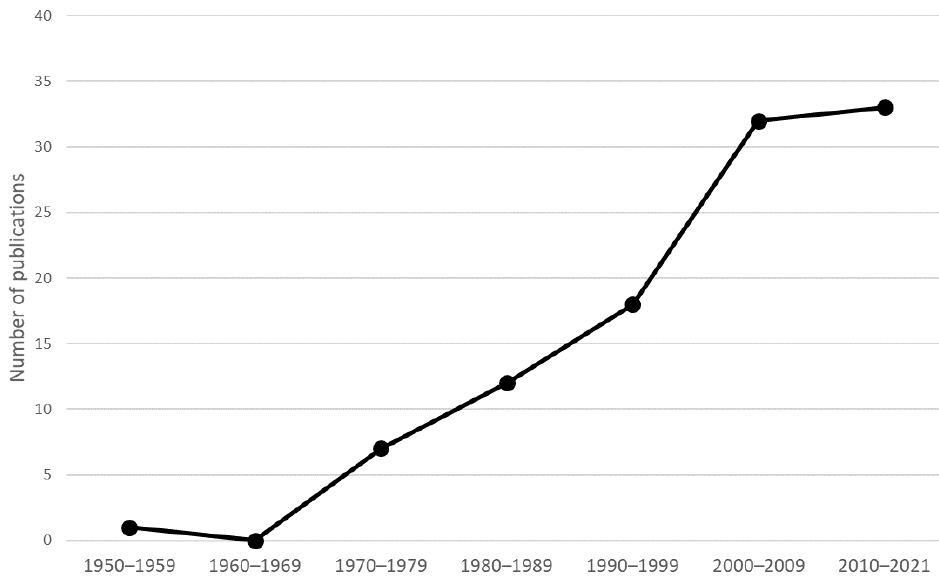
Figure 2. Number of publications focusing on avian community associations with southeastern managed pine systems, categorized in decadal increments (1950–2021).